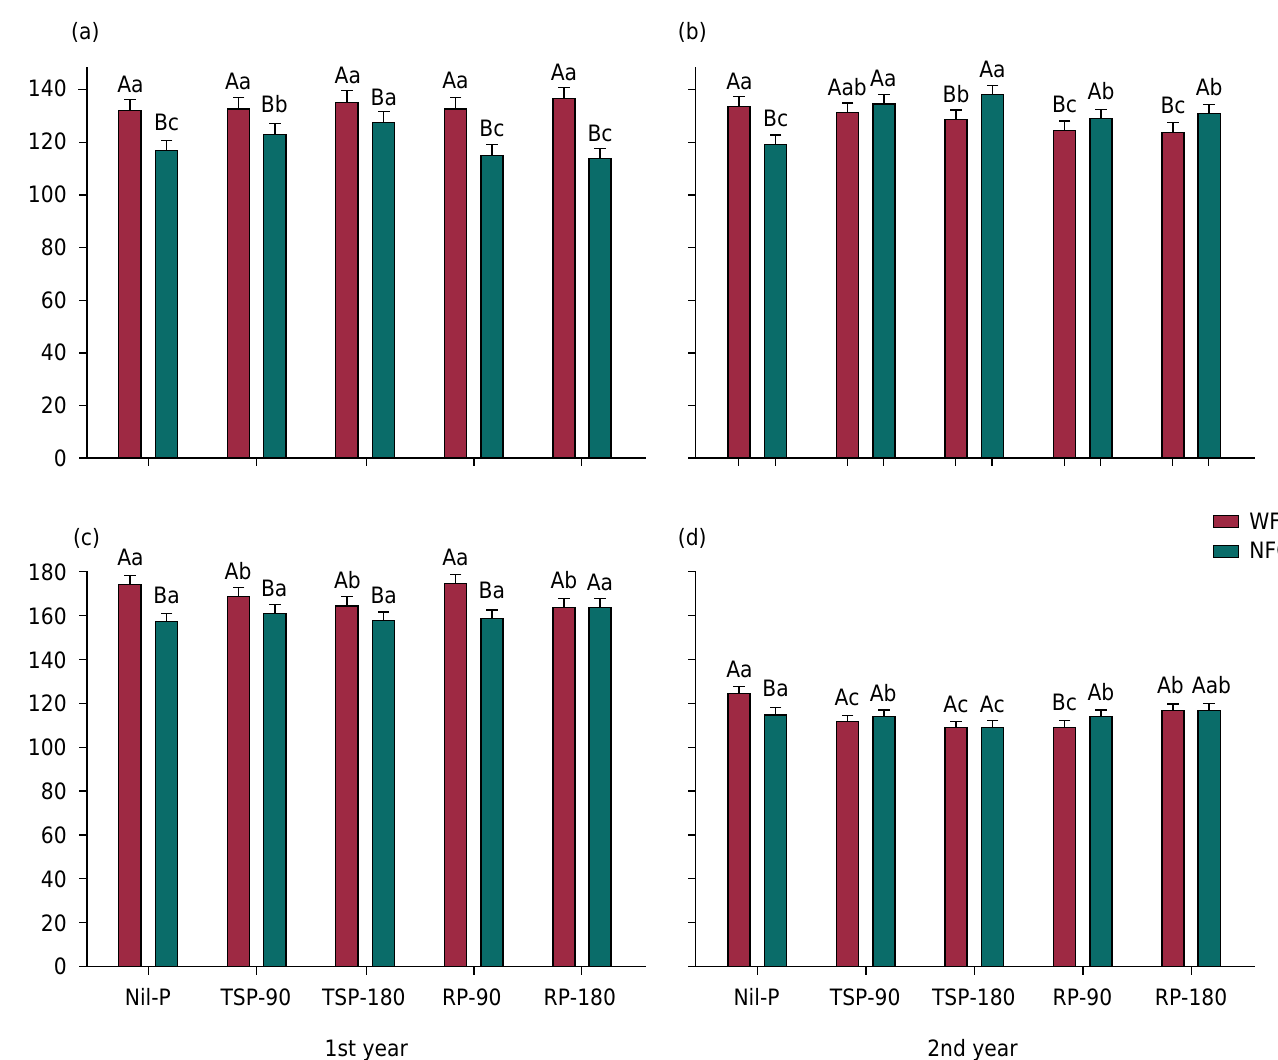
Figure 3. Yield of sugarcane at Agudos in 2014 (a) and 2015 (b) and at Macatuba in 2015 (c) and 2016 (d) affected by filter cake addition and P sources and rates. NFC = no filter cake; WFC = with filter cake; Nil-P = no phosphate sources; TSP = triple superphosphate; RP = rock phosphate; 1st and 2nd years are 2014 and 2015 at Agudos and 2015 and 2016 at Macatuba, respectively. Within each fertilizer treatment, means followed by the same capital letter were not significantly different, and within each filter cake treatment, means followed by the same small letter were not significantly different at p<0.05 by LSD test, error bars represent standard